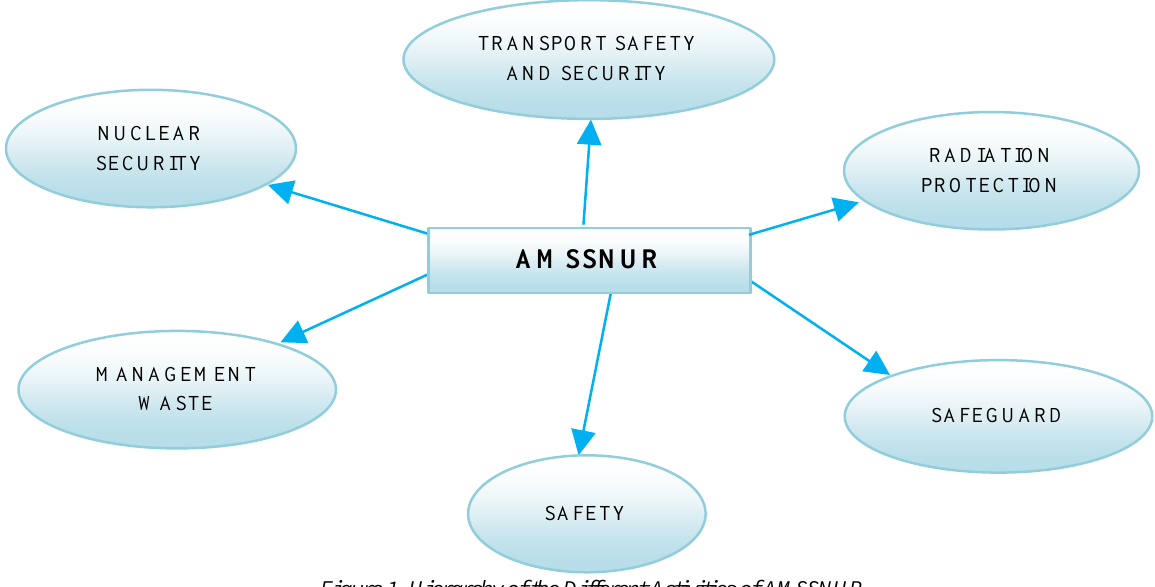
Figure 1. Hierarchy of the Different Activities of